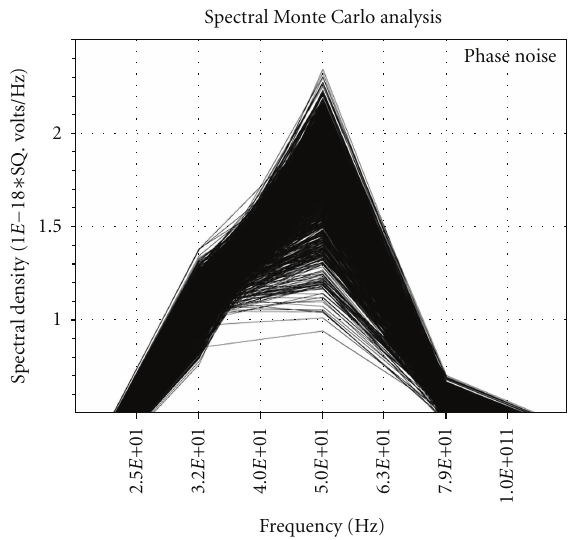
Figure 15: Monte Carlo simulation of phase noise “skirt” near a center frequency of ≈ 50 GHz for the VCO cell in